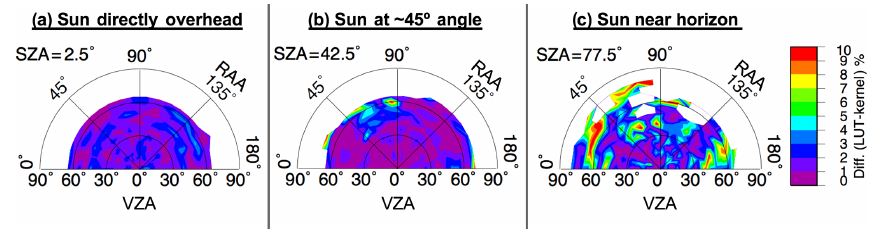
Figure 7. Percent difference in predicted anvil reflectance between the LUT shown in Fig. 3 and the kernel-based BRDF model shown in Fig. 6.